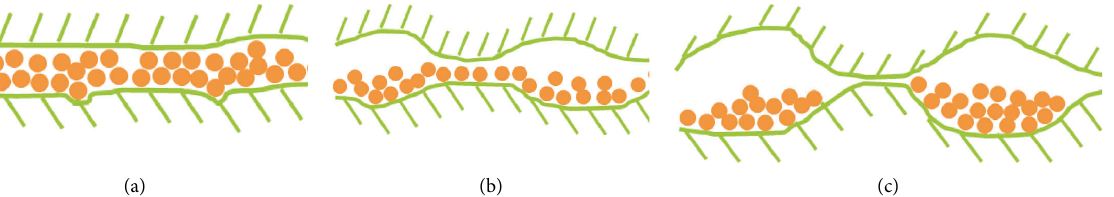
Figure 11: The lubrication mechanisms of SiO 2 nanoparticles under different height-diameter ratios (a) λ : 1, (b) λ : 6, and (c) λ :